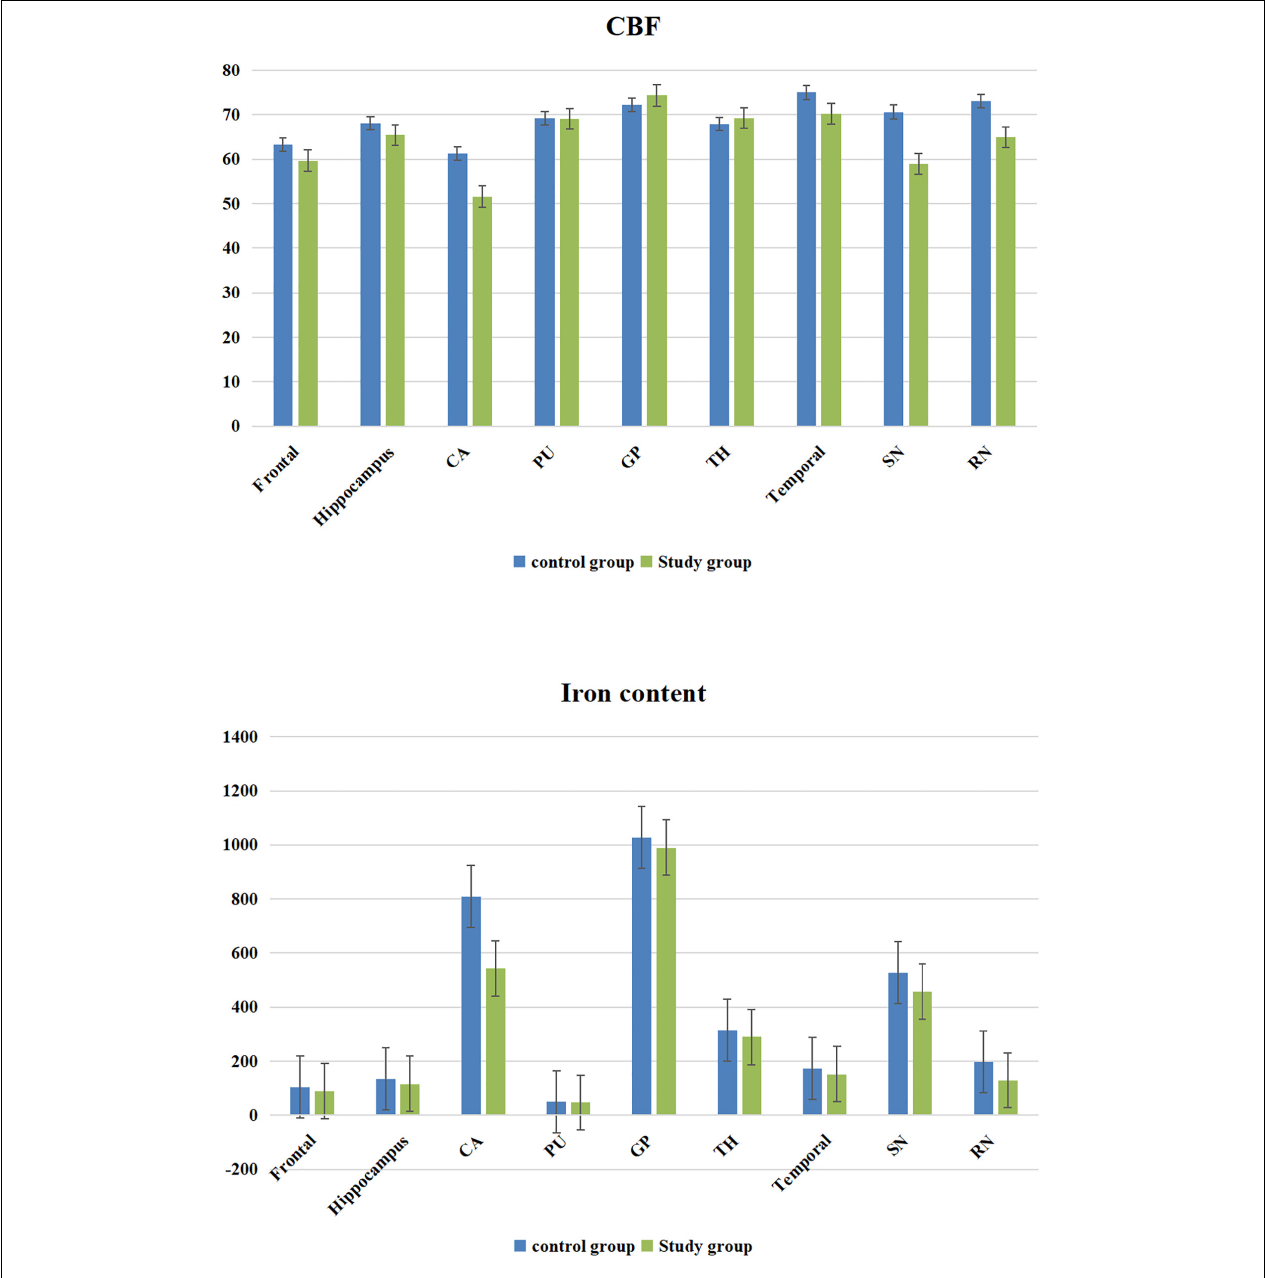
FIGURE 2 | Cerebral blood flow (CBF) value and iron content bar